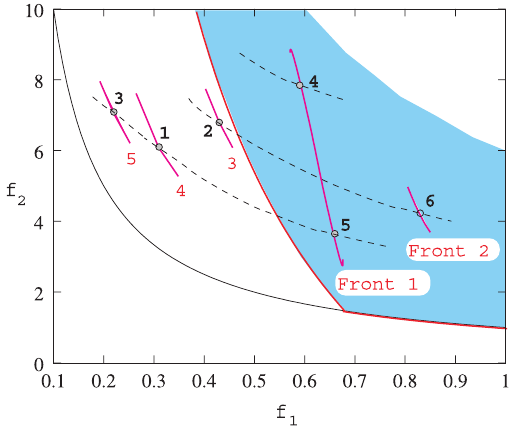
Fig. 2. Non-constrain-dominated